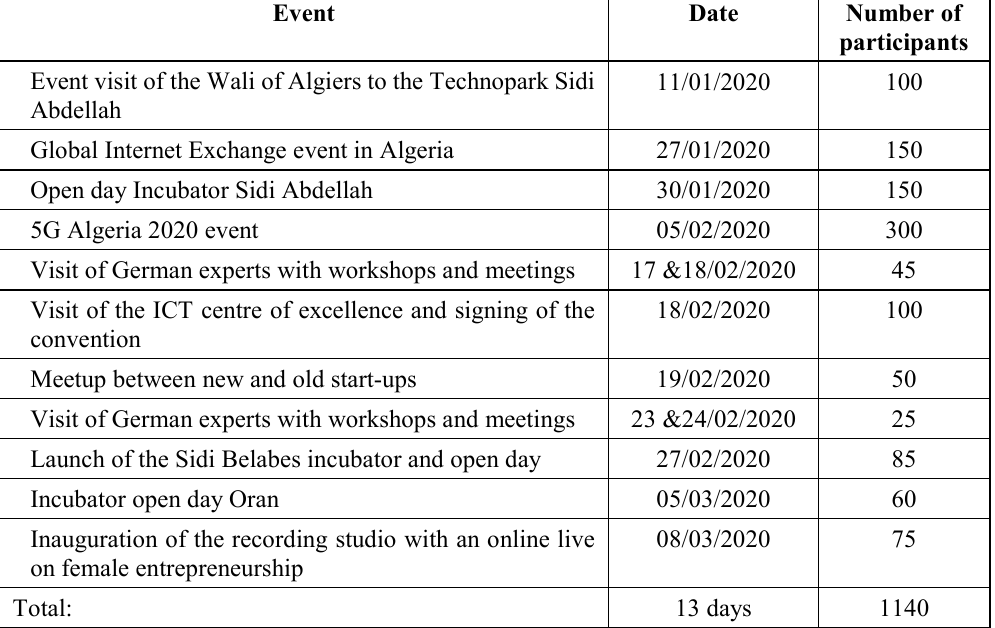
Table 7. Consolidated Table of Events Organised during the 1 st Quarter of